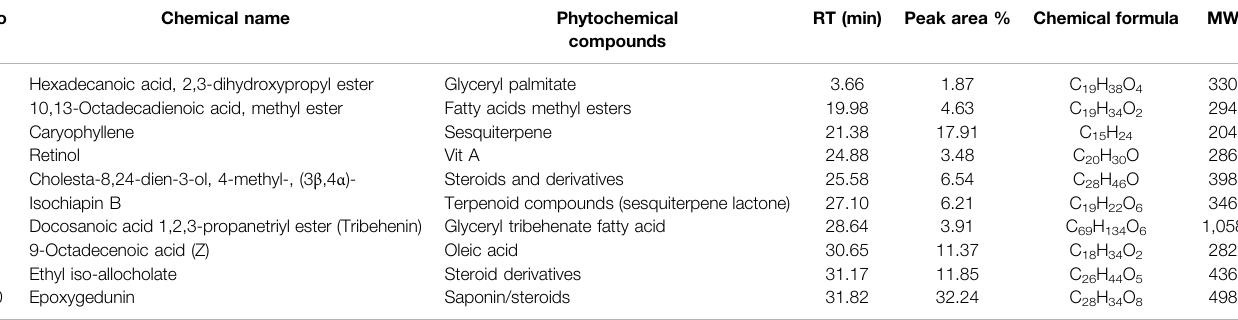
MW, molecular weight; RT, retention time.